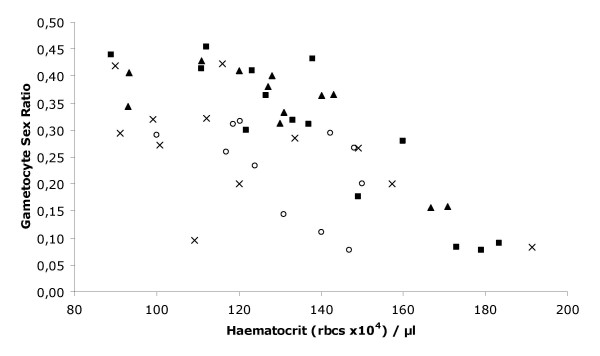
Gametocyte sex ratios (proportion male) of mixed vs. single clone infections compared with their corresponding haematocrits (red blood cell density) measured on the same day of infection. Each individual infection was measured daily for both these parameters until either the host died or the infection was cleared by the host (thus until the peak of infection). Thai or SL clone alone, 8 infective mosquitoes per bird; Mixed infections were initiated using 8 or 4 infective mosquitoes from batches of mosquitoes infected with either of the clones. Thai clone (squares); SL clone (open circles); 8+8 mixed clones (triangles); 4+4 mixed clones (crosses).